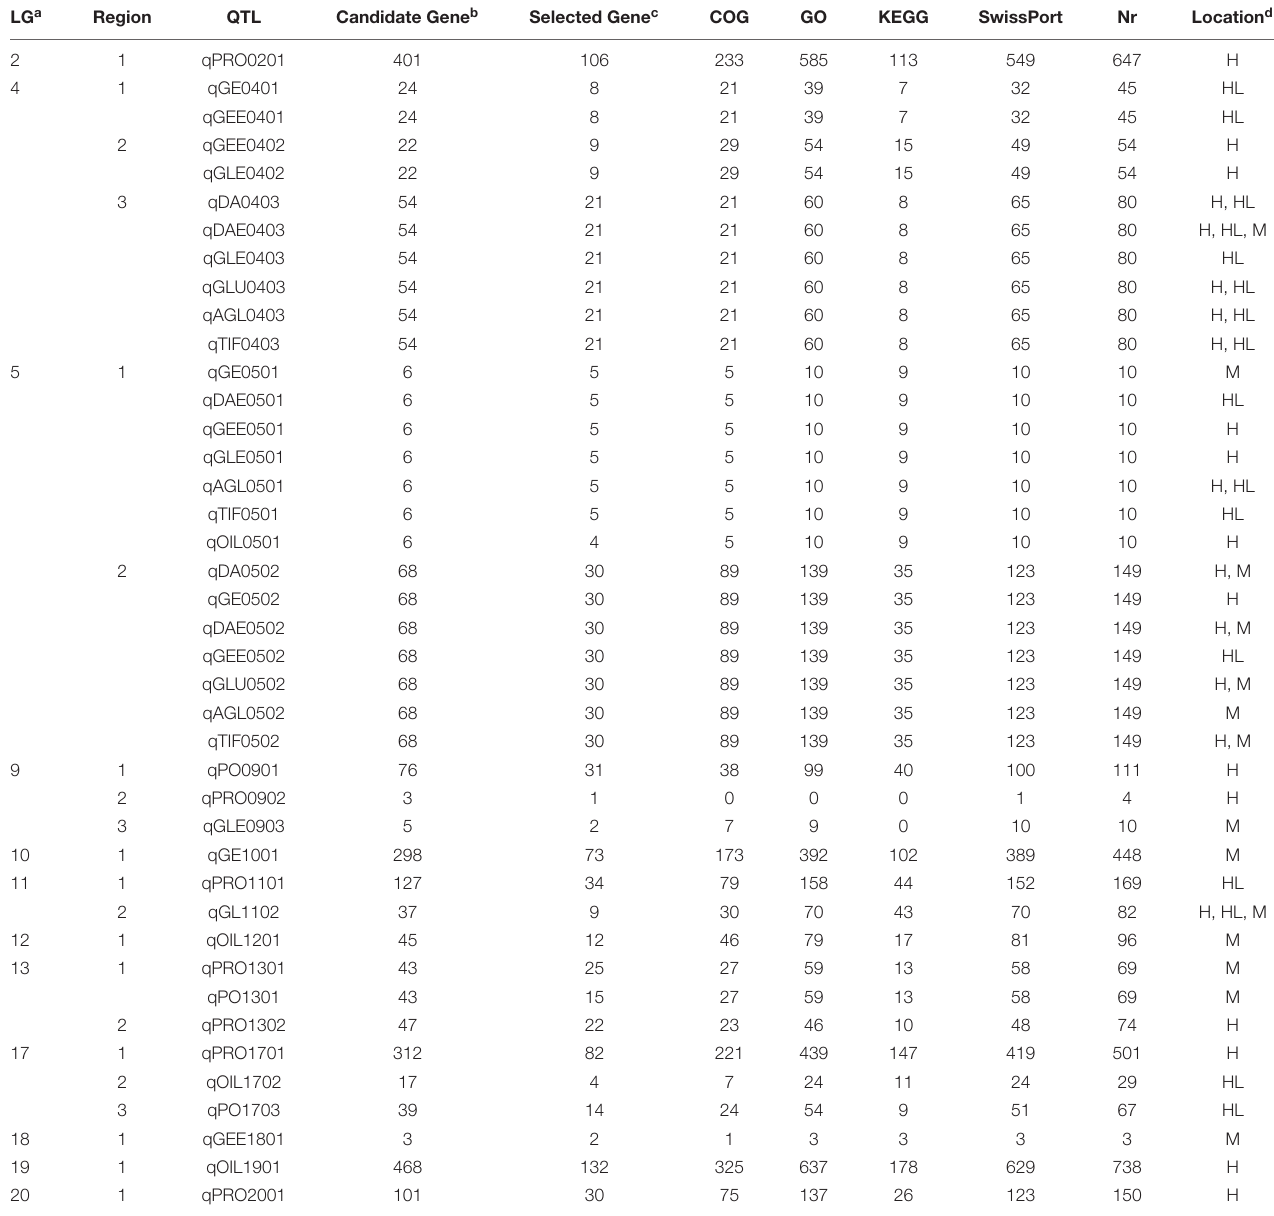
TABLE 6 | The gene functional annotation of